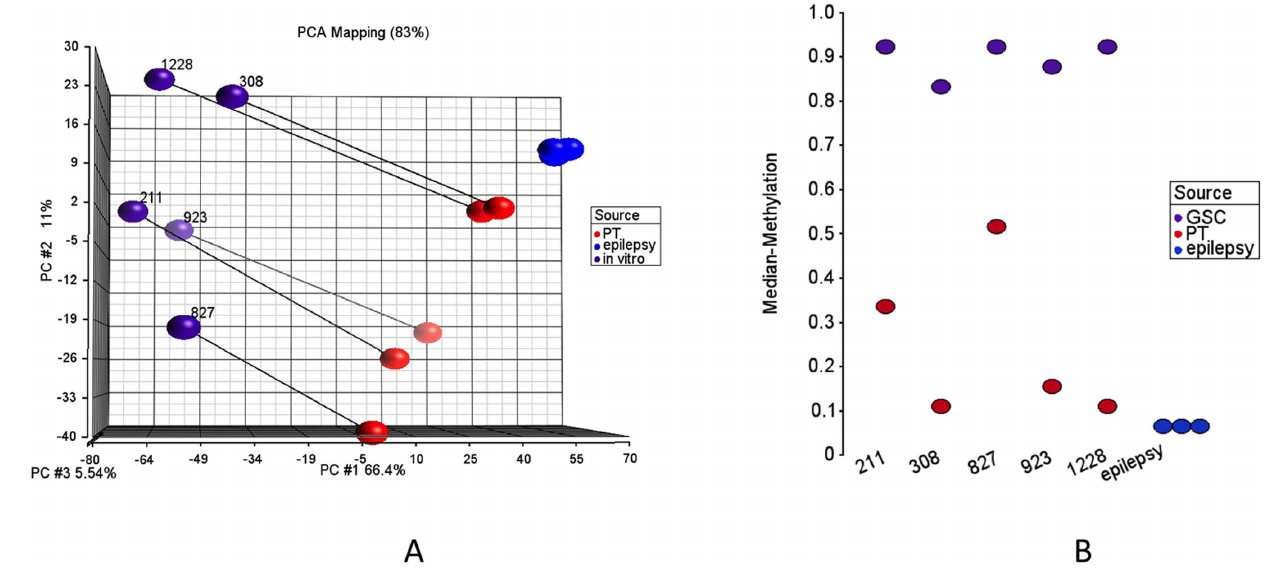
Figure 2. DNA methylation profiles for patient tumors and invitro GSCs. (A) Principle Component Analyses (PCA) of 3847 methylation sites with standard deviation more than 0.35. PT represents patient tumor and in vitro represents the corresponding in vitro GSCs. Matched PT- in vitro pairs are connected with lines. (B) Median methylation values for each sample based on selected 3847 sites.